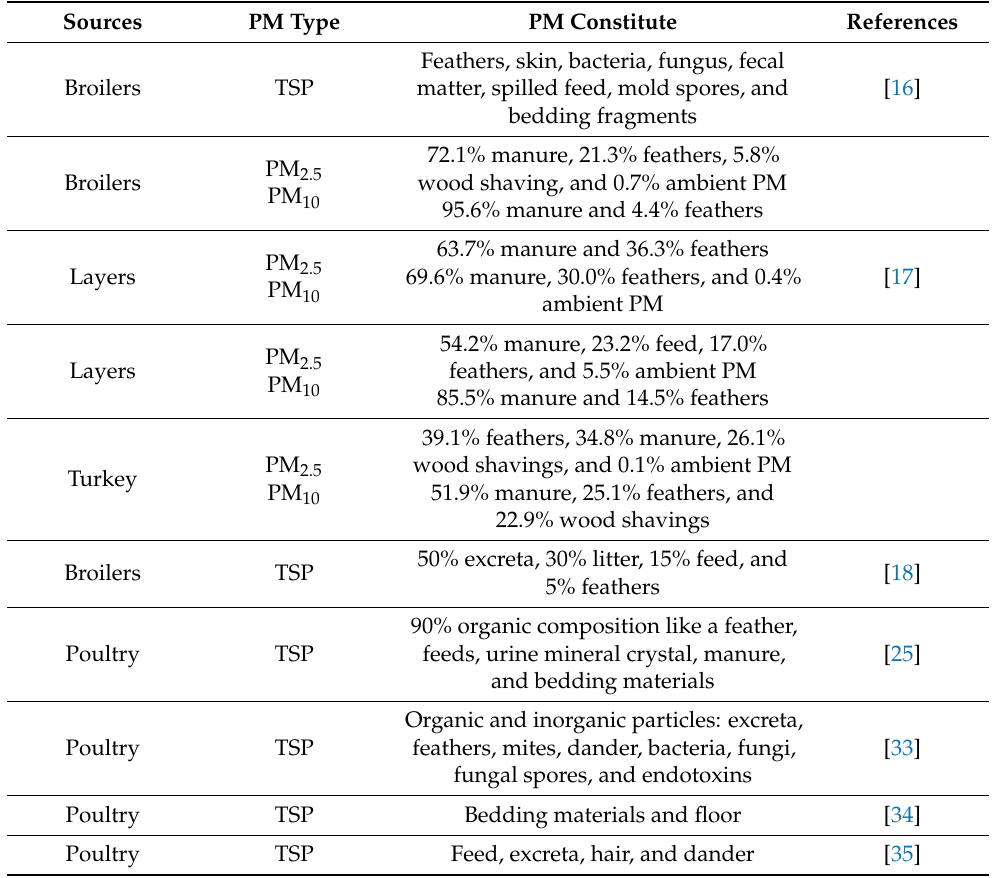
Table 1. Particulate matter composition varies with different housing